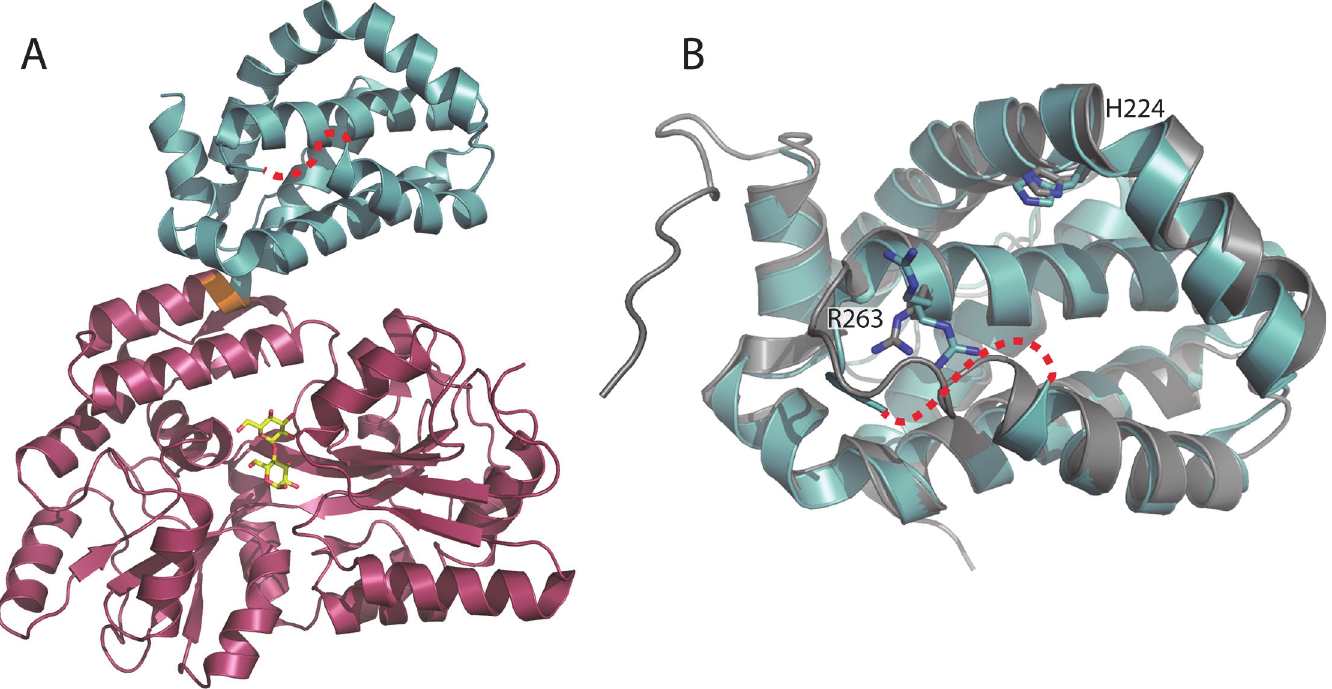
Fig 3. The structure of Apo MBP-MCL1 determined at 1.90 Å . (A) The MBP domain (red) is connected by a short GS linker (orange) to MCL1 173 – 321 (blue). A portion of alpha helix four is not ordered in the structure (red dashed-line). Maltose ligand is shown in yellow. (B) The MCL1 domain is structurally very similar to the NMR structure of Apo-MCL1